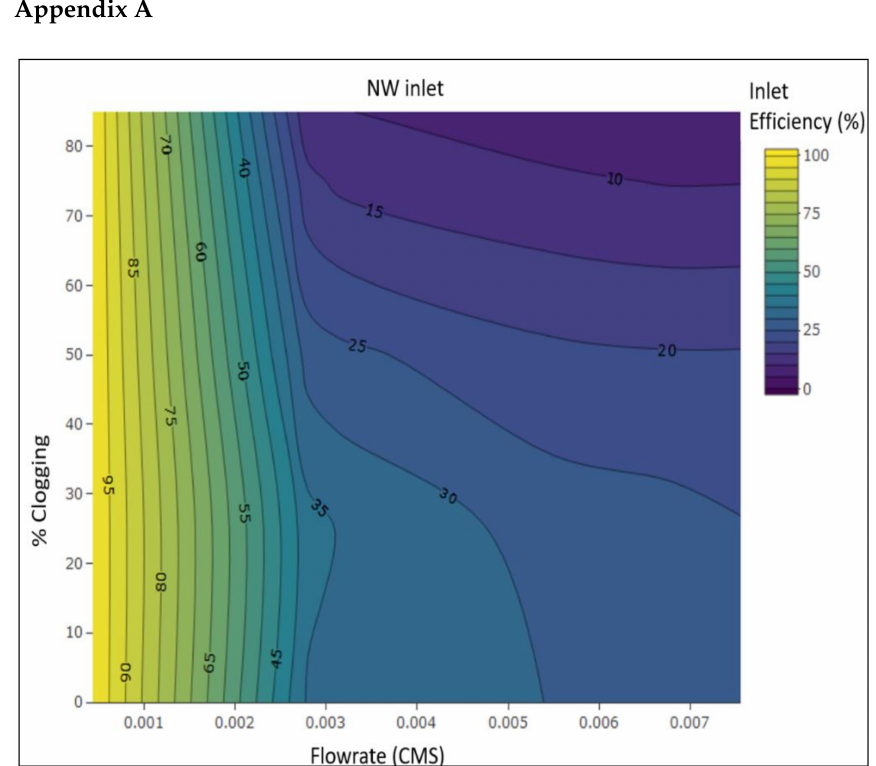
Figure A1. (Reprinted from Shevade et al., 2020). Effect of increased flowrate and inlet clogging on inlet efficiency for NW inlet.